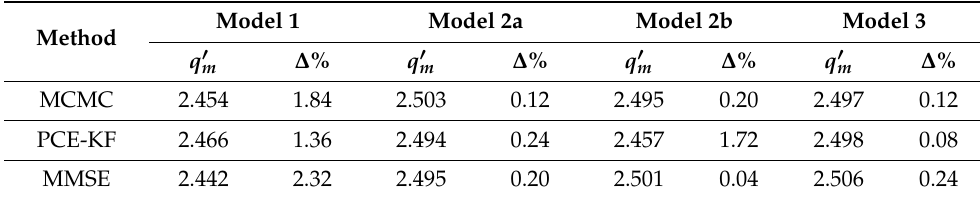
Table 2. Performance of the different updating procedures: comparison of posterior mode q (cid:48) m and q true = u + σ = 2.5.